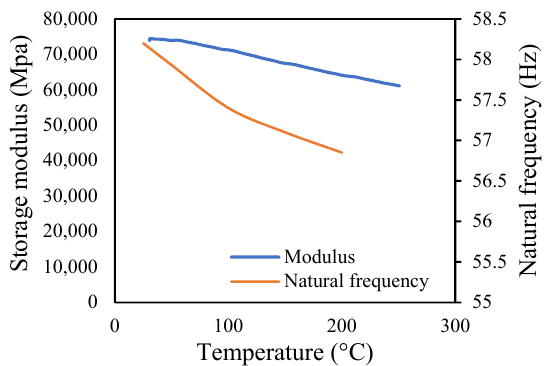
Figure 28. Modulus and frequency at different temperatures.